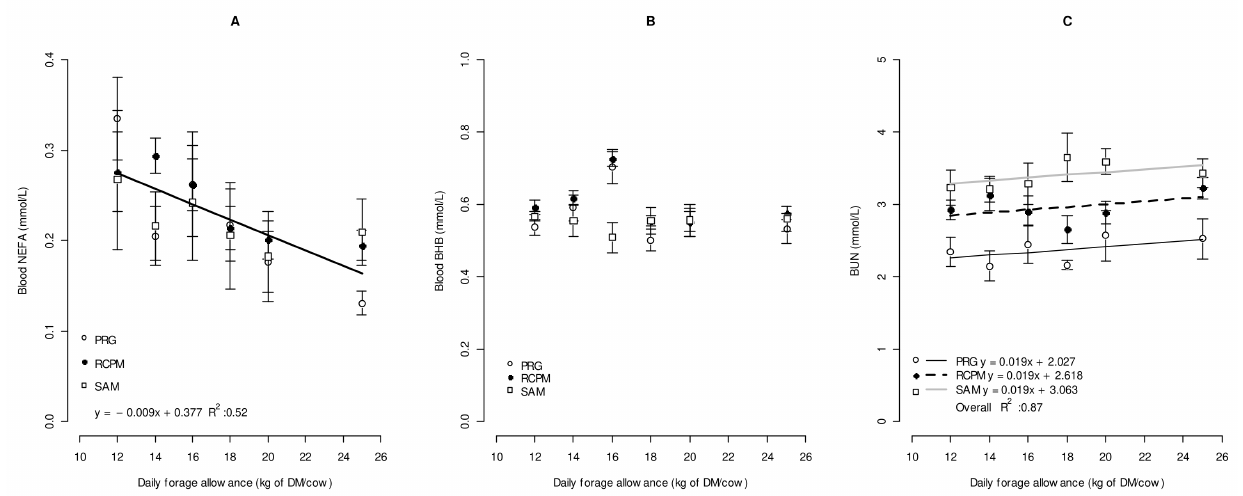
Figure 3. ( A ) Non-esterified fatty acid (NEFA); ( B ) beta-hydroxybutyrate (BHB); and ( C ) blood urea nitrogen (BUN) concentrations in the blood of early lactation dairy cows grazing three different forage types at six forage allowances. Forage types included PRG, perennial ryegrass monoculture; RCPM, perennial ryegrass, white clover and plantain mixture; and SAM, spatially adjacent monocultures of perennial ryegrass, white clover and plantain. Separate forage type relationships ( C ) are only shown when the addition of this factor improved the variance accounted for by the model. No regression could be fitted to BHB data ( B ). Symbols are means ± SEM ( n = 4).